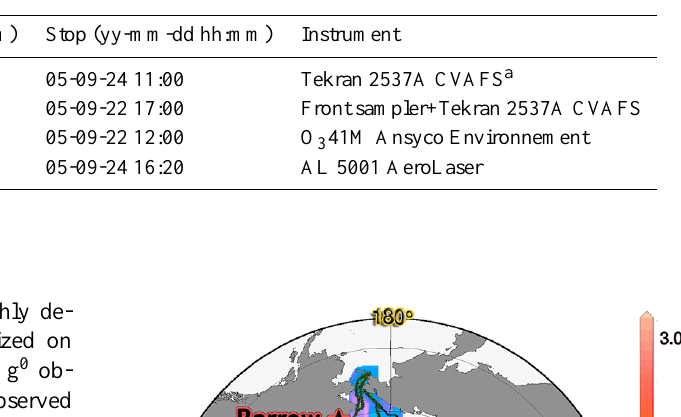
Table 1. Information concerning the air sampling protocol onboard IB Oden (4th deck).